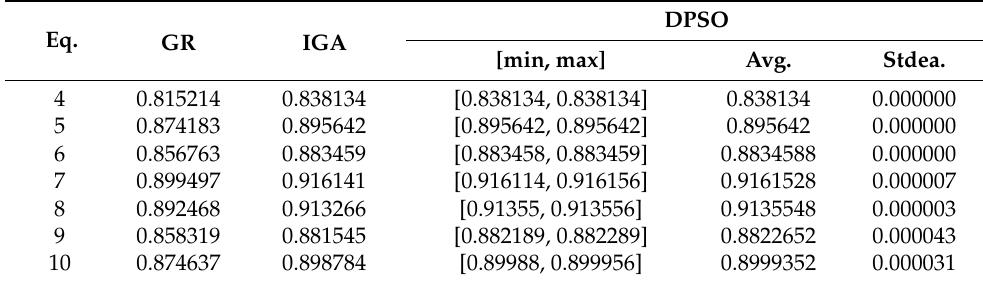
Table 8. Comparison table of evaluation values of